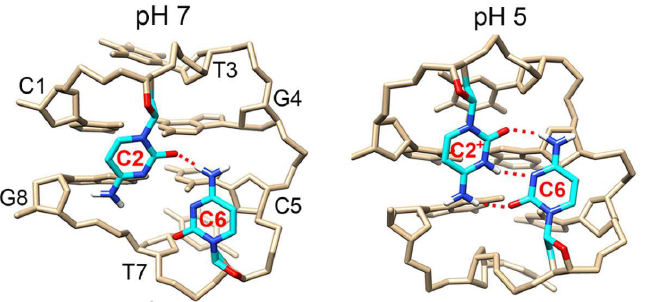
Figure 1. The averaged solution nuclear magnetic resonance (NMR) structure of the CCTG MDB at pH 7 (PDB ID: 5GWL) and pH 5 (PDB ID: 7D0Z). C2 and C6 formed predominantly a one-hydrogen- bond mispair at pH 7, whereas they formed a stable three-hydrogen-bond mispair at pH 5 with C2 being